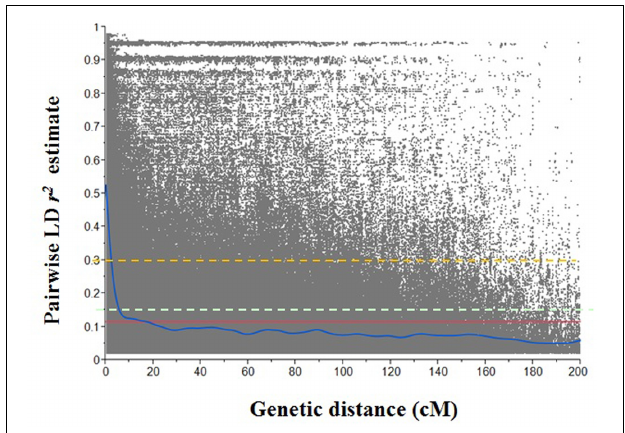
FIGURE 3 | Scatter plot of pairwise single nucleotide polymorphism (SNP) linkage disequilibrium (LD) r 2 over inter-marker genetic distance of the Ethiopian durum wheat genome. The blue solid curve represents the smoothing spline regression model fit to LD decay. Red solid line represents the mean r 2 line ( r 2 = 0.12) of the whole genome; cyan dash line represents the 95 th percentile unlinked r 2 line ( r 2 = 0.15) of the whole genome; orange dash line represents the standard critical r 2 line ( r 2 = 0.30) of the whole